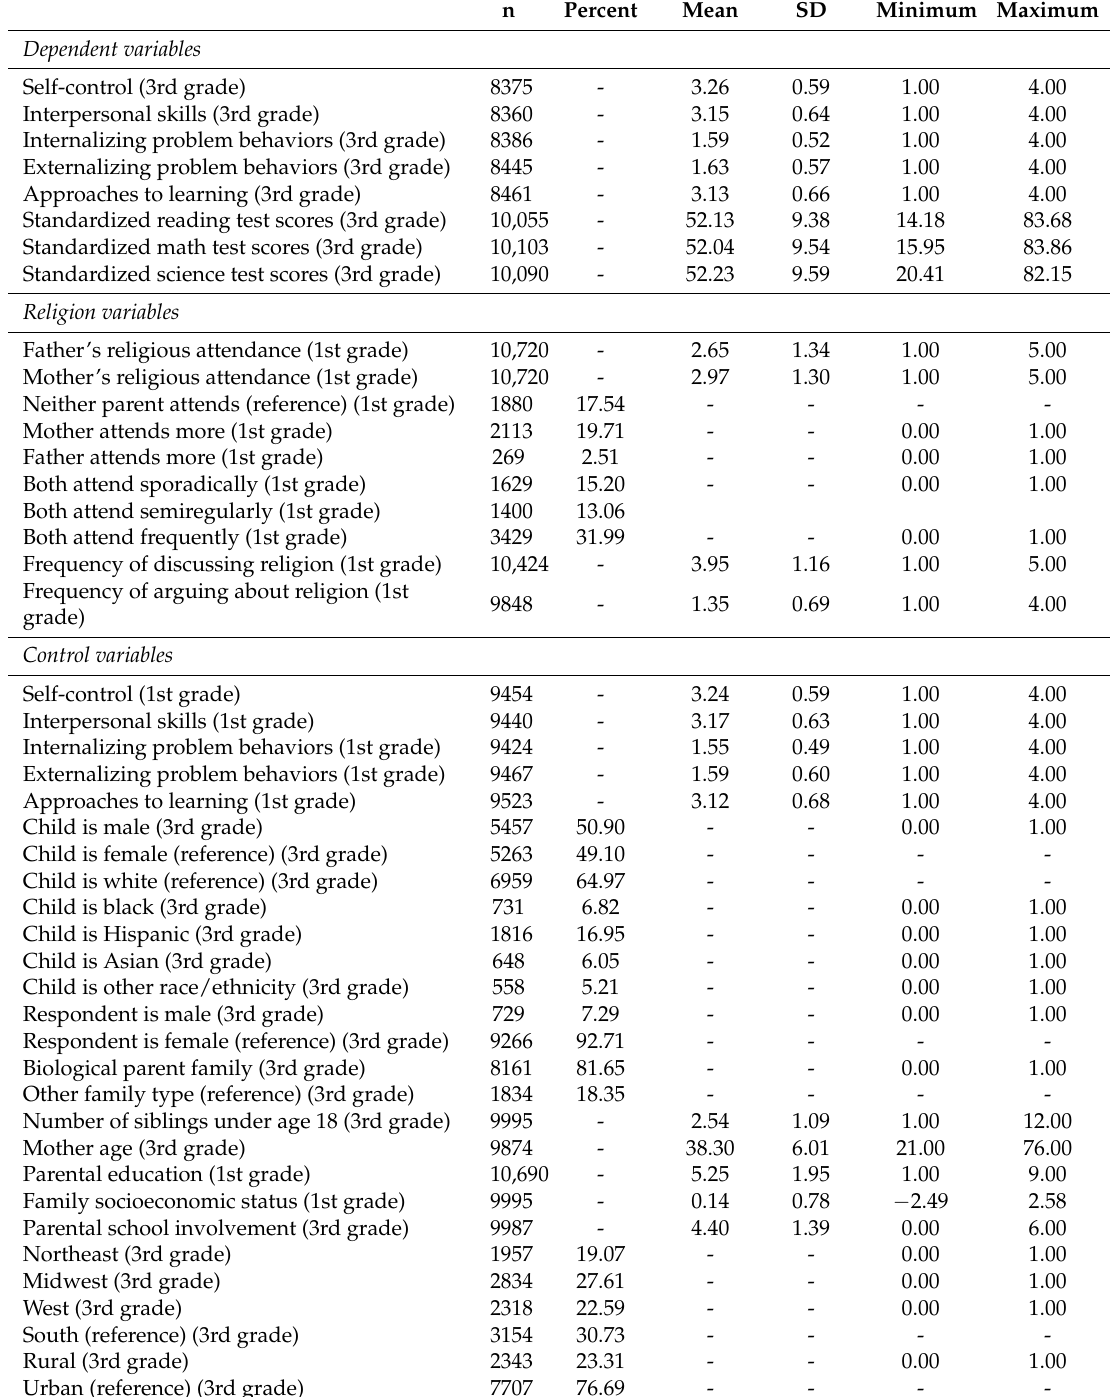
Table 1. Early Childhood Longitudinal Study (ECLS) 3rd Grade Sample Characteristics before Multiple